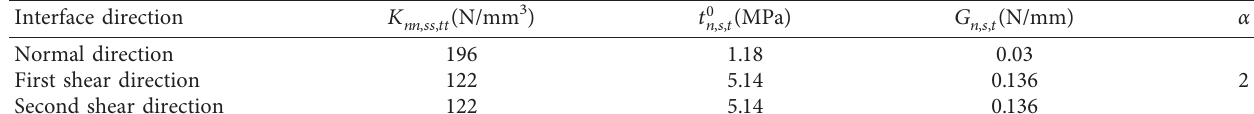
Table 6: Constitutive parameters.